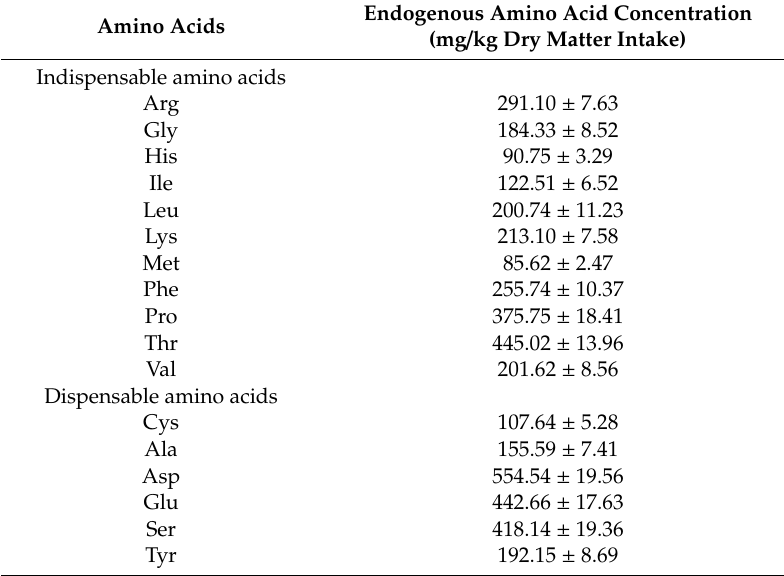
Table 7. Concentration of endogenous amino acid losses used to standardize the amino acid digestibility.